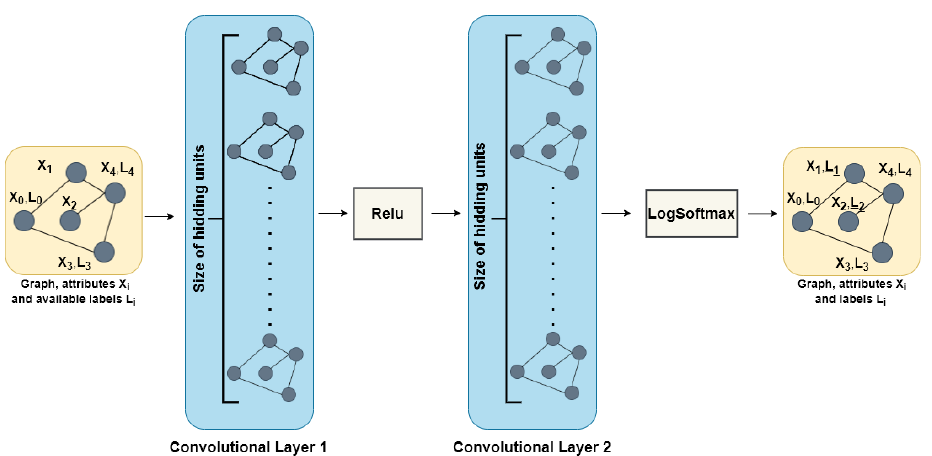
Figure 1. The Graph Convolutional Network models’